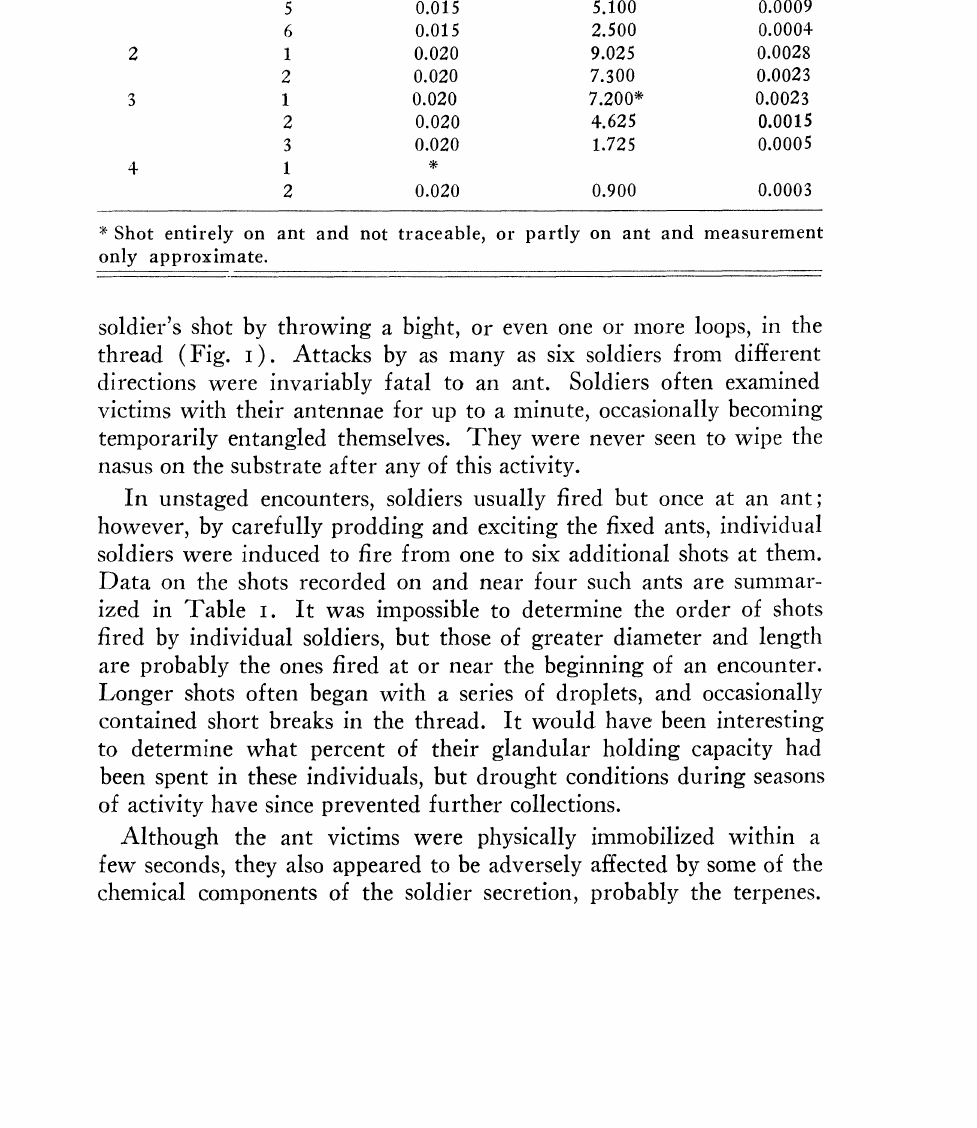
Table 1. Measurements of shots or threads fired by four soldiers of Tenuirostritermes tenuirostris at fixed, living ants in the laboratory. Soldier Shot Av.